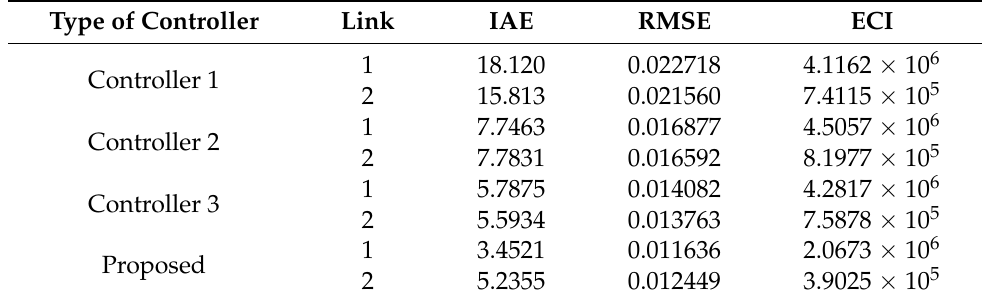
Table 2. Tracking performance